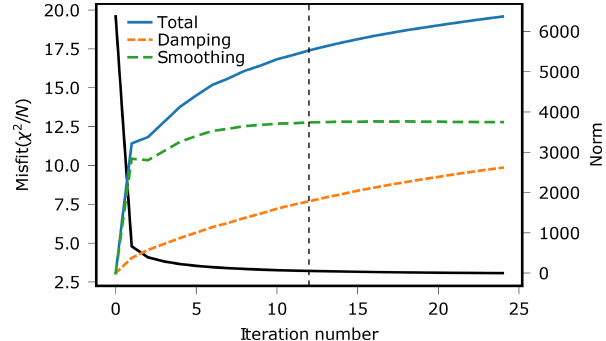
Figure 12. Misfit reduction for 24 inversion iterations. Smoothing norm and damping norm are displayed by the green and orange lines; total norm is displayed in blue. We use the model after it- eration 12 as our final model, as the misfit reduction becomes in- significant hereafter, whilst the smoothing term (model roughness) has reached its maximum and only the damping norm (model vari- ation) continues to